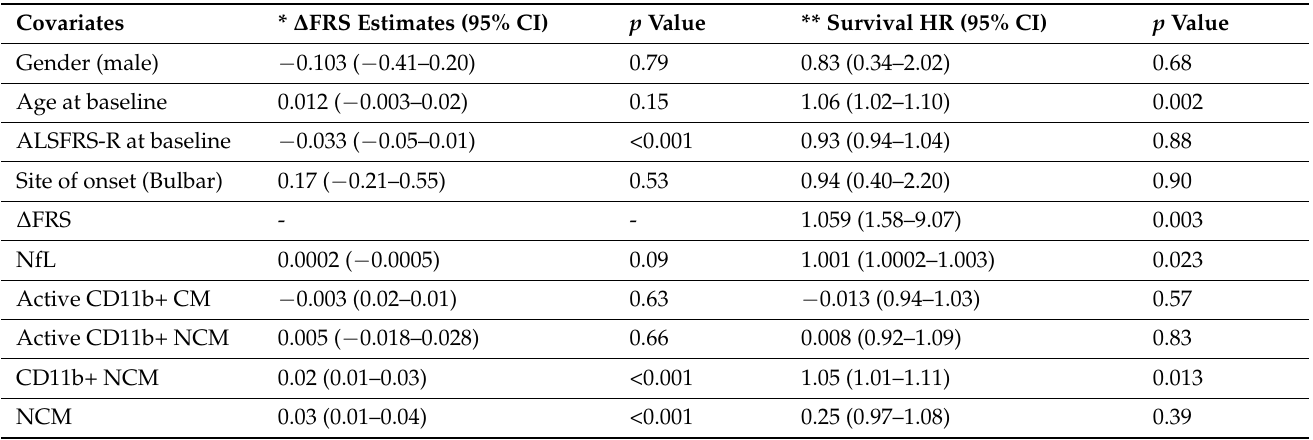
Table 2. Impact on ∆ FRS and survival of clinical and biological independent